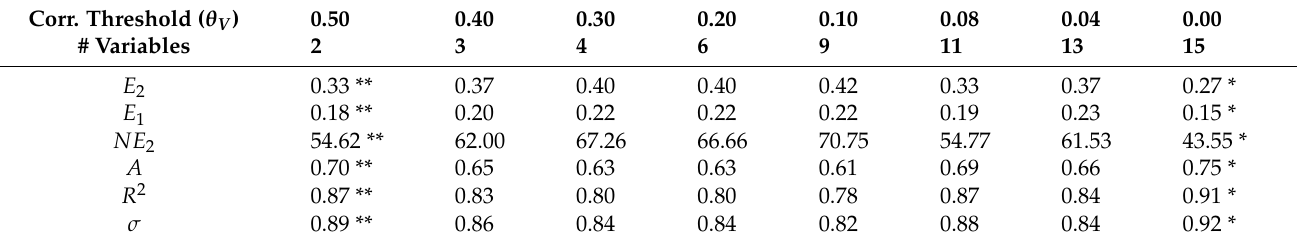
Table 6. Performance of the proposed model according to the variable composition. The first row presents the thresholds of Pearson correlation coefficients of the forecasting target (i.e., solar irradiance) with the other meteorological variables ( θ V ). The second row shows the number of variables chosen based on the thresholds. Additionally, * and ** indicate that the proposed model had the best and second-best performances with the corresponding θ V , respectively. The remaining hyper-parameters were set as L o = 12, L p = 1, and N =